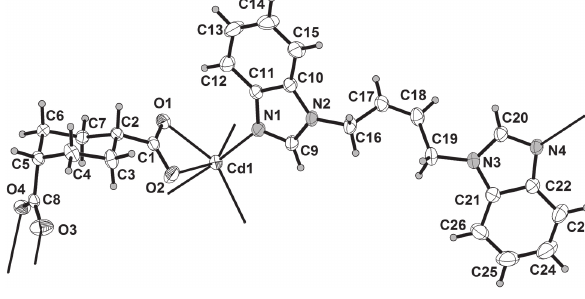
Table 1: Data collection and handling.